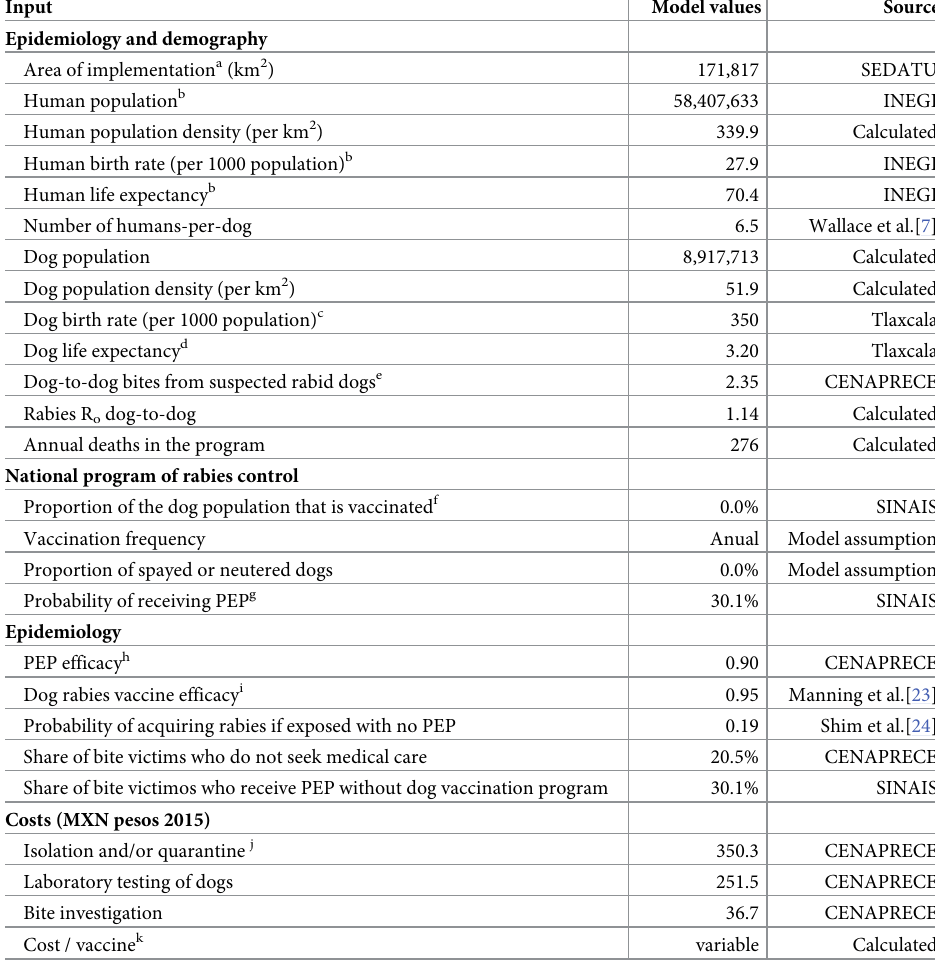
Table 1. Primary demographic and epidemiological data used to define the counterfactual scenario without a national dog rabies vaccination campaign, 1990, using RabiesEcon [20].